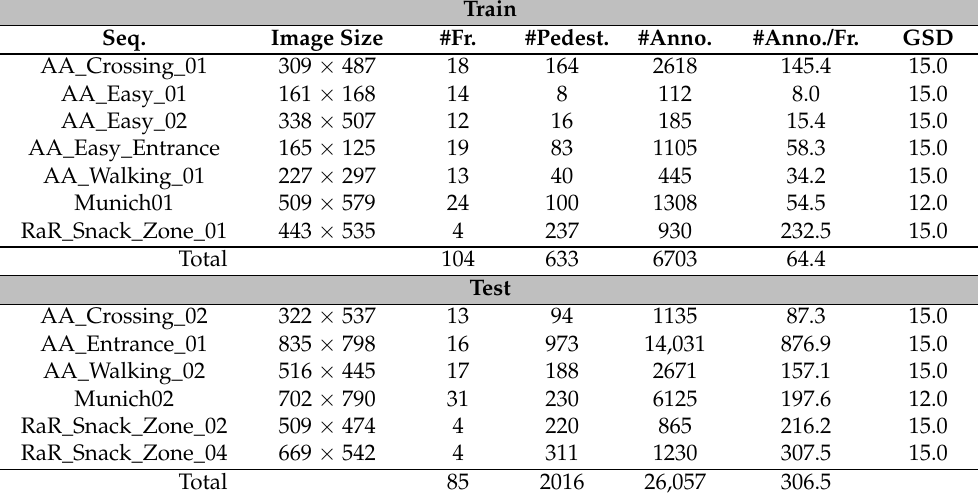
Table 1. Statistics of the KIT AIS pedestrian dataset.